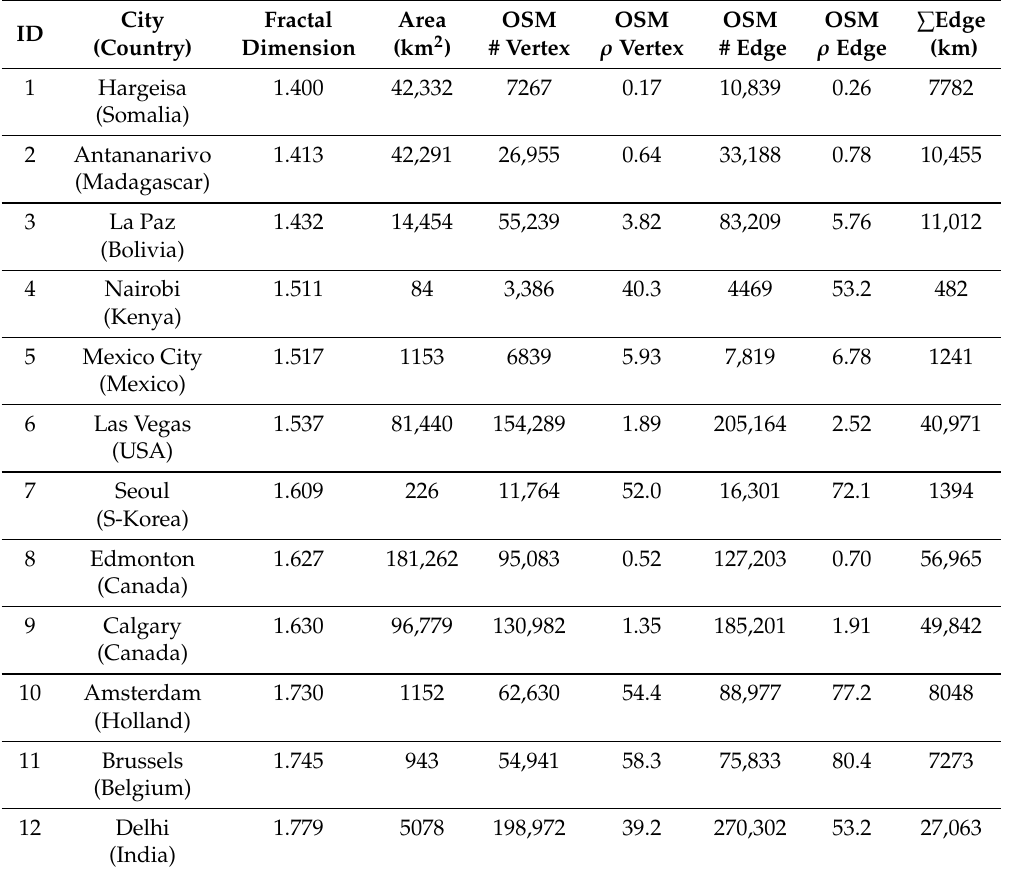
Figure 8. Graph ( left ) between the start–end points’ geo-separation and corresponding optimal route length for all five group-counts (for Brussels). Note that a polygon is sketched to show the spread of each data point. It should be noted how polygons drift away from the mean-line for increased complexity. On the right , we have slope and R 2 values of trendlines induced by each | V s | instance for all 15 cities, where there are decreases with increases in complexity. The decreasing R 2 and slope value along the x -axis depicts the complex networking of urban street-roads, and shows how optimal route length gets similar irrespective of the start–end points’ spatial separation. Table 1. General statistics of all selected cities (Figure